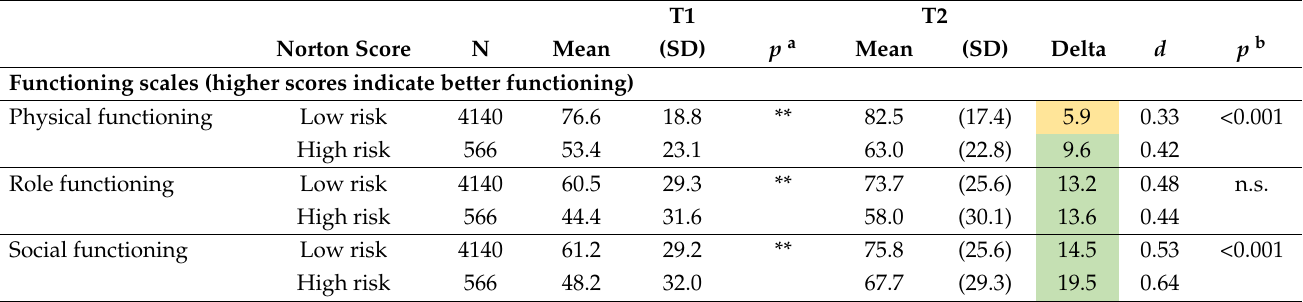
Table 4. EORTC QLQ-C30 and HADS mean scores before and after rehabilitation, stratified by Norton scale risk